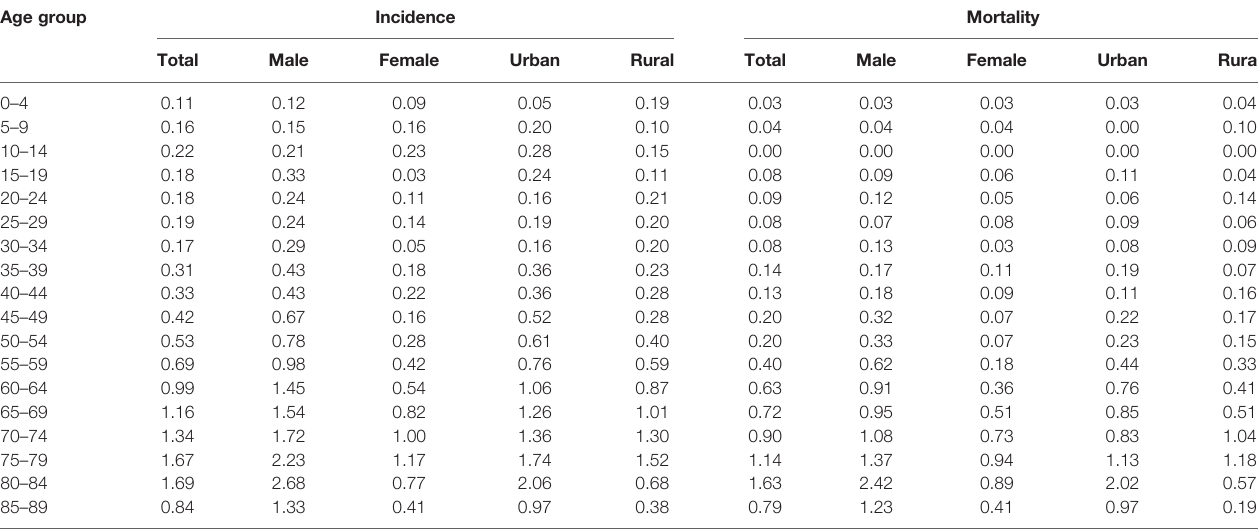
TABLE 3 | Age-speci fi c incidence and mortality rates by sex and area of peripheral T-cell lymphoma in Beijing from 2007 to 2018 (1/100,000). Age group